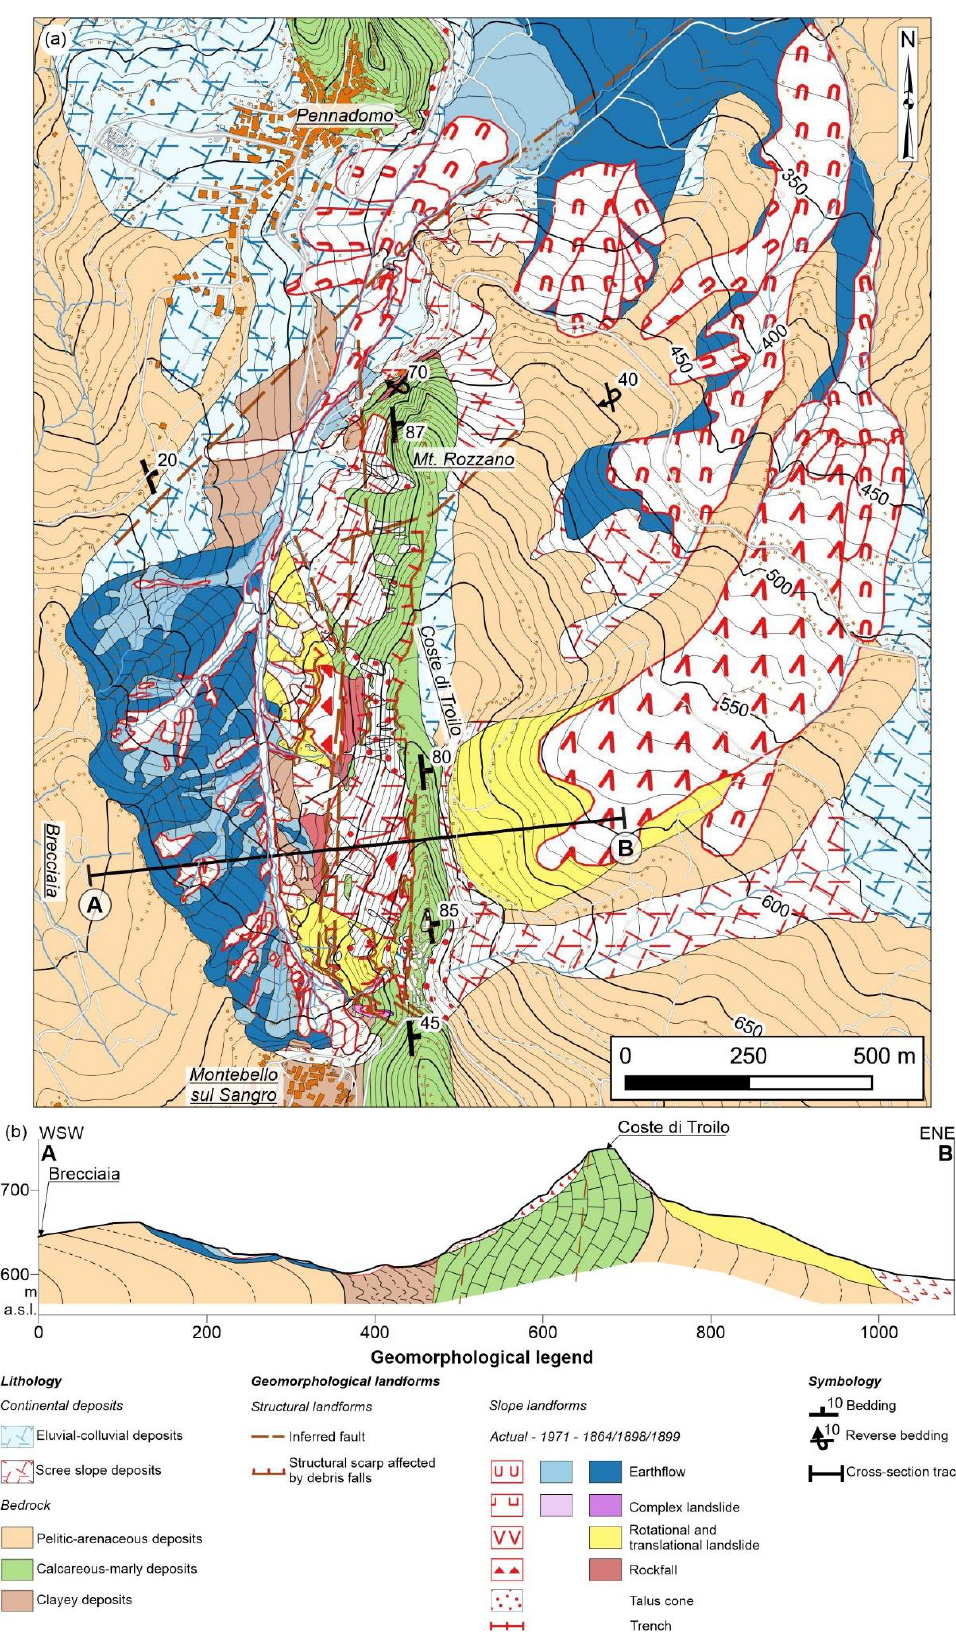
Figure 10. Montebello sul Sangro landslide: ( a ) multitemporal geomorphological map (derived from unpublished data and modified and updated from [87]); ( b ) geomorphological cross-section.